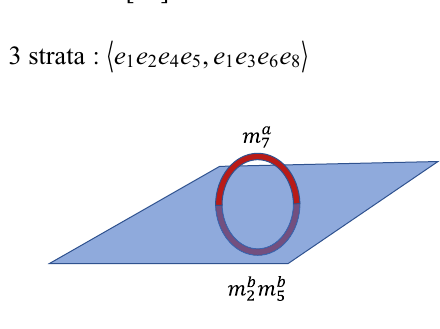
FIG. 5. Example of a magnetic condensation on a 2